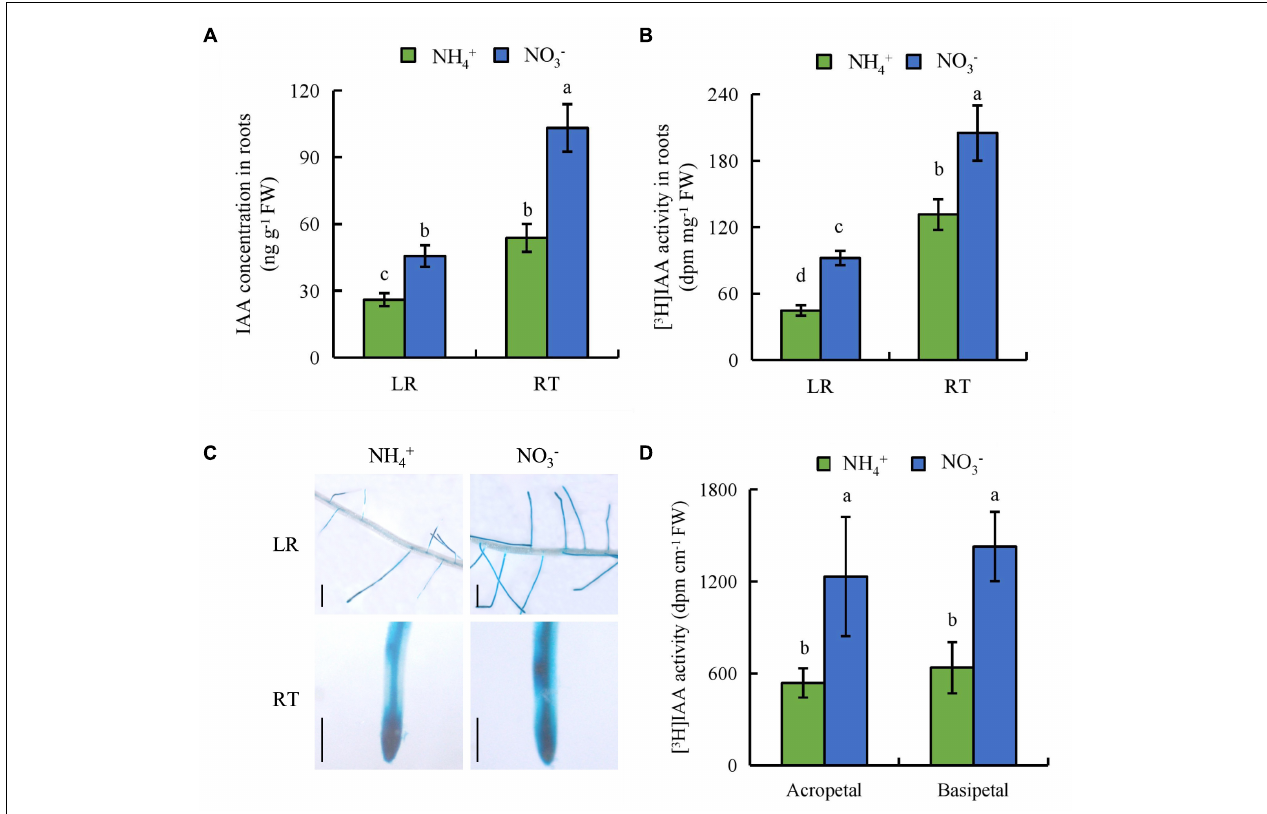
FIGURE 5 | IAA concentration, [ 3 H]IAA transport and histochemical localization of DR5::GUS activity in rice seedlings. Rice seedlings were grown in hydroponic media containing NH 4 + and NO 3 − for 14 days. (A) , IAA concentration in roots; (B,D) [ 3 H] IAA activity in the root tip (RT) and lateral root zone (LR); (C) , DR5::GUS , a specific reporter that contains seven repeats of a highly active synthetic auxin response element and can reflect the in vivo auxin level. Roots were stained for GUS activity for 2 h at 37 ◦ C. Bar = 1 mm. Data are means ± SE and bars with different letters indicate significant difference at P < 0.05 tested with